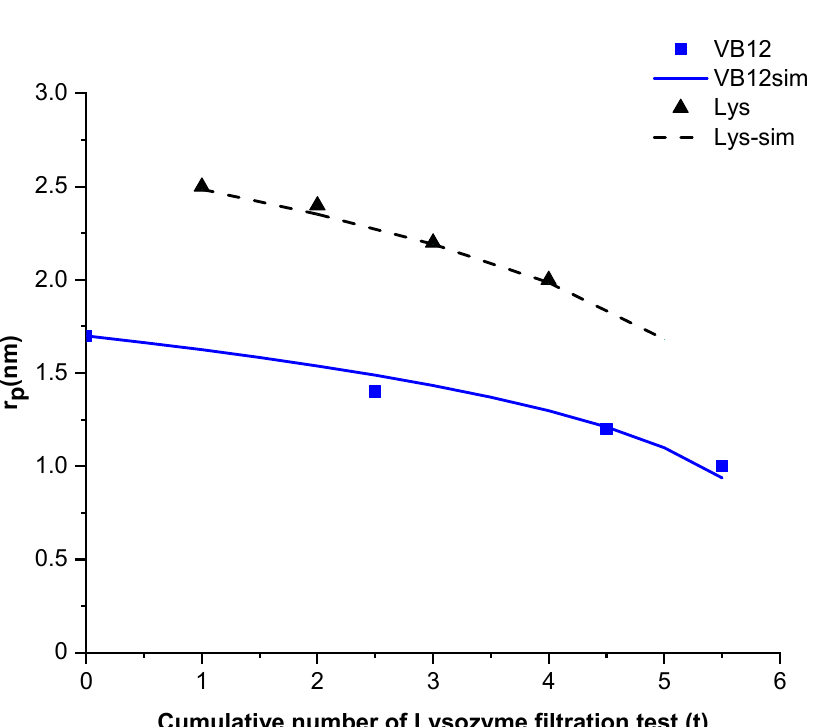
Figure 4. Mean pore radius estimated from filtration experiments and calculation of neutral solute (series 1: Vitamin B12 and Lysozyme).